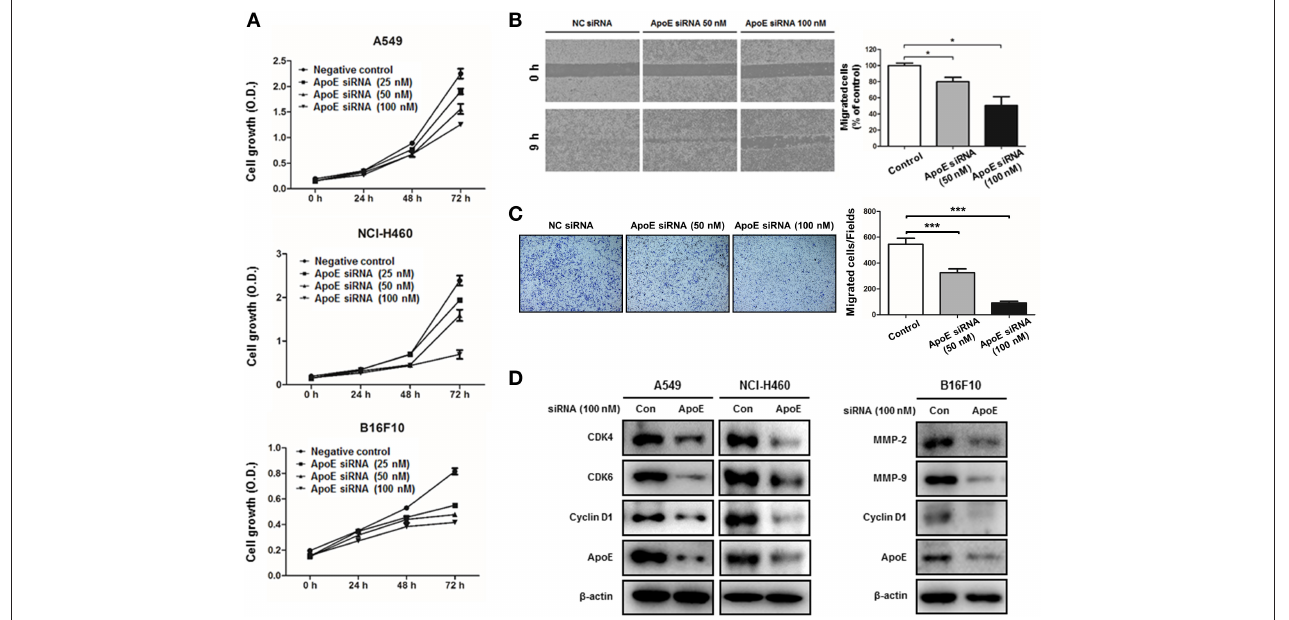
FIGURE 3 | Effect of ApoE knockdown on cell growth and migration in cancer cells. (A) Lung cancer cells (A549 and NCI-H460) and B16F10 cells were plated on 96-well plates (1 × 10 3 cells per well) and transfected with the negative control (NC) siRNA or ApoE siRNA (25, 50 or 100nM) for indicated time points. Cell growth was measured by MTT assay ( n = 5). (B) B16F10 cells were seeded on µ -Slide and transfected with NC siRNA or ApoE siRNA (50 or 100nM). Cells were cultured to confluent on µ -Slide ( n = 3). After silicon-wall removal, cells were allowed to migrate into cell-free zone. Cell migration was detected at various times post-silicon-wall removal by a microscopy at 100X. (C) B16F10 cells transfected with NC siRNA or ApoE siRNA (50 or 100nM) were seeded onto transwell inserts pre-coated with collagen on the bottom side and loaded into culture well filled with growth medium containing 10% FBS as a chemoattractant ( n = 3). After 18h incubation, transwell inserts were fixed and stained by crystal violet solution. Bar graphs represent cell-migration distance or number of migrated cells. * p < 0.05 and *** p < 0.0001. (D) Cells were transfected with NC siRNA or ApoE siRNA (100nM) for 24h. Cell extracts were analyzed by Western blotting. Samples (30 µ g) were resolved on SDS– PAGE and detected with specific antibodies against CDK4, CDK6, Cyclin D1, MMP-2, MMP-9 and ApoE. β -actin was used as a loading